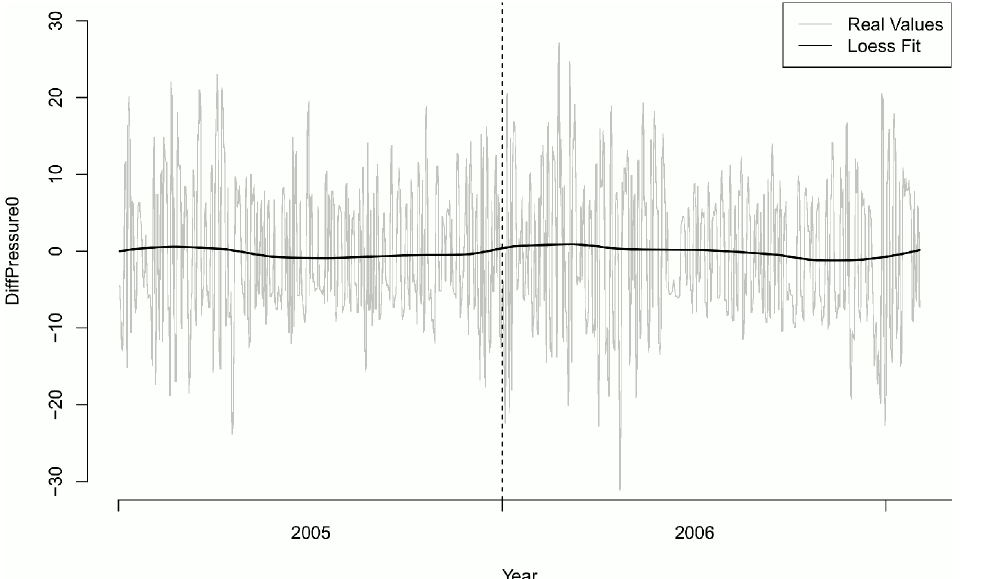
Fig 2. Change in air pressure over time. Station